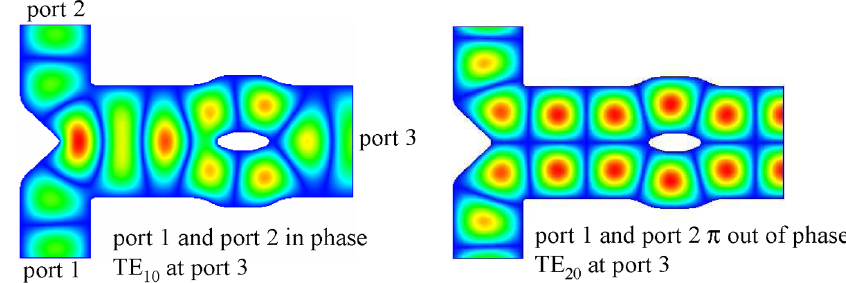
FIG. 1. (Color) HFSS [21] simulation of the basic planar dual-mode